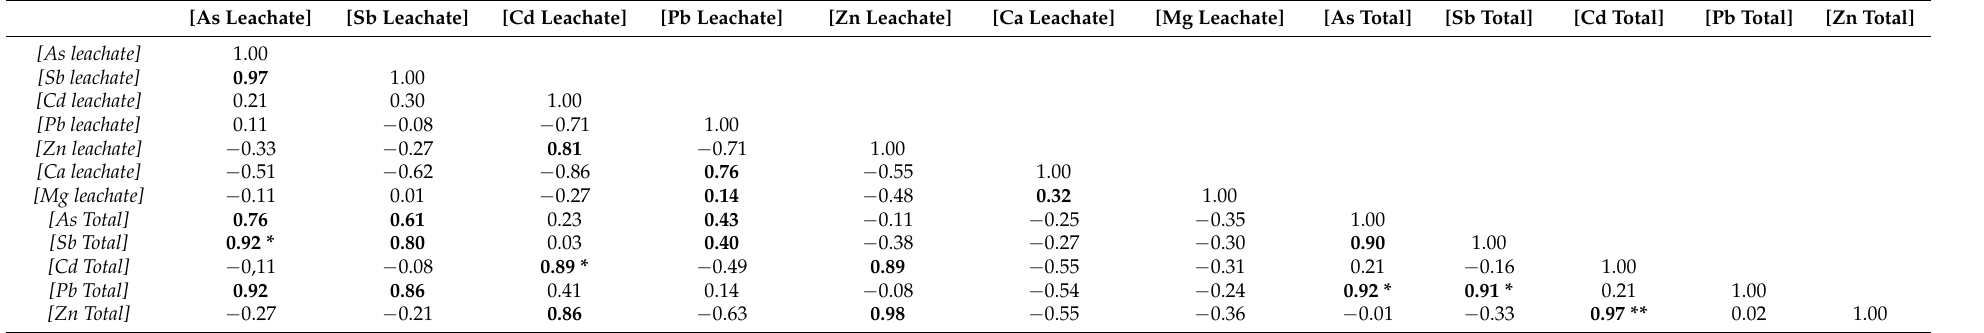
Table 6. Correlation matrix (R) between total and leachate concentrations of